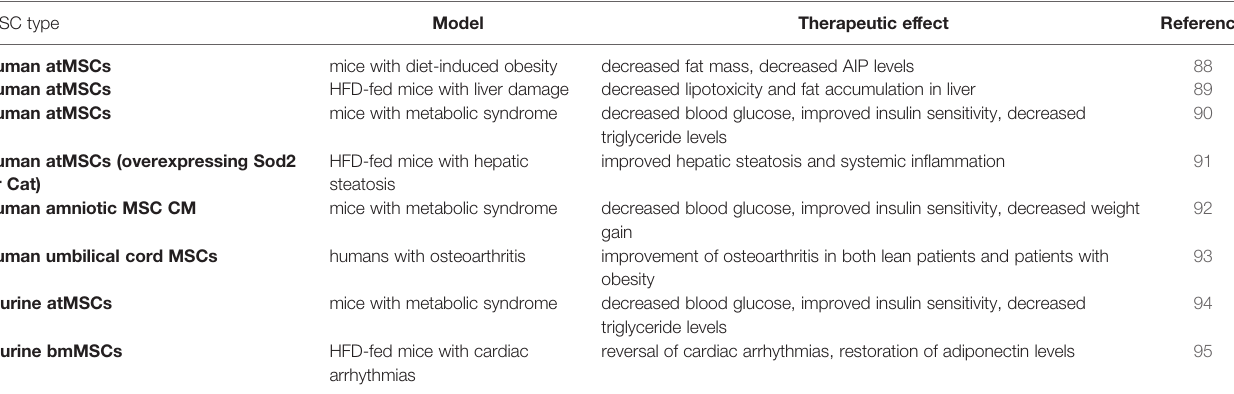
TABLE 1 | Therapeutic effect of lean MSCs in